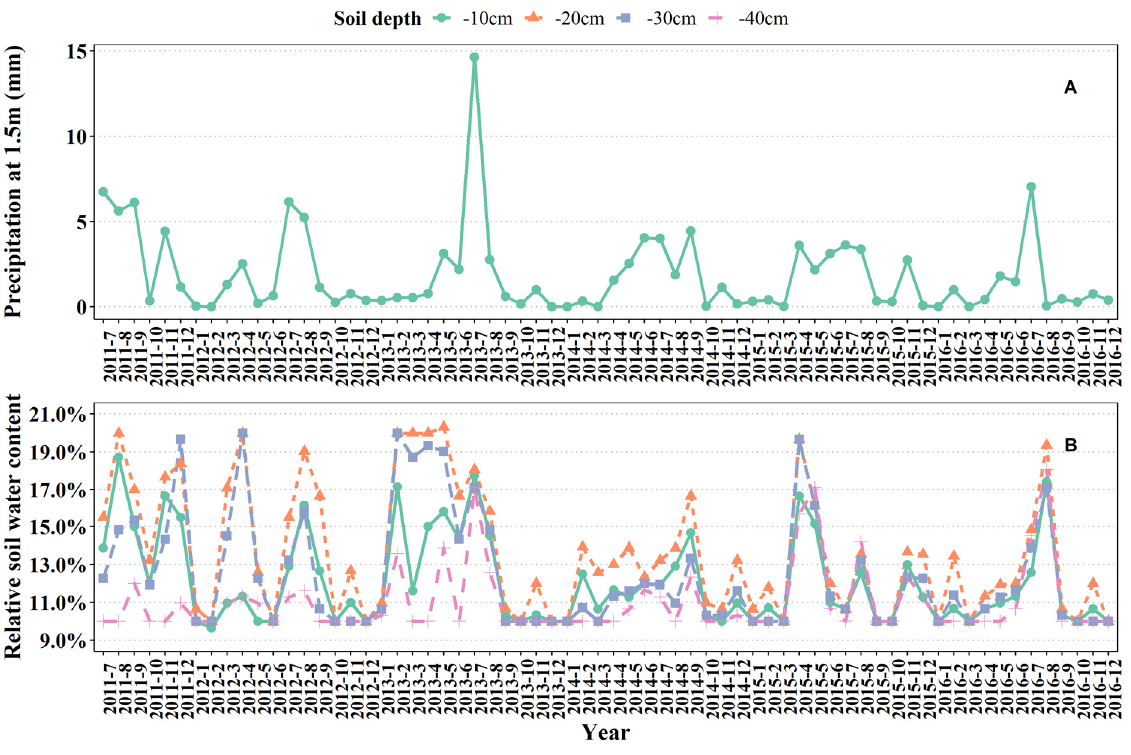
Figure 3. Variation of precipitation and relative soil water content in the Quercus acutissima plantation from 2011 to 2016. ( A ) Precipitation at 1.5 m; ( B ) relative soil water content.